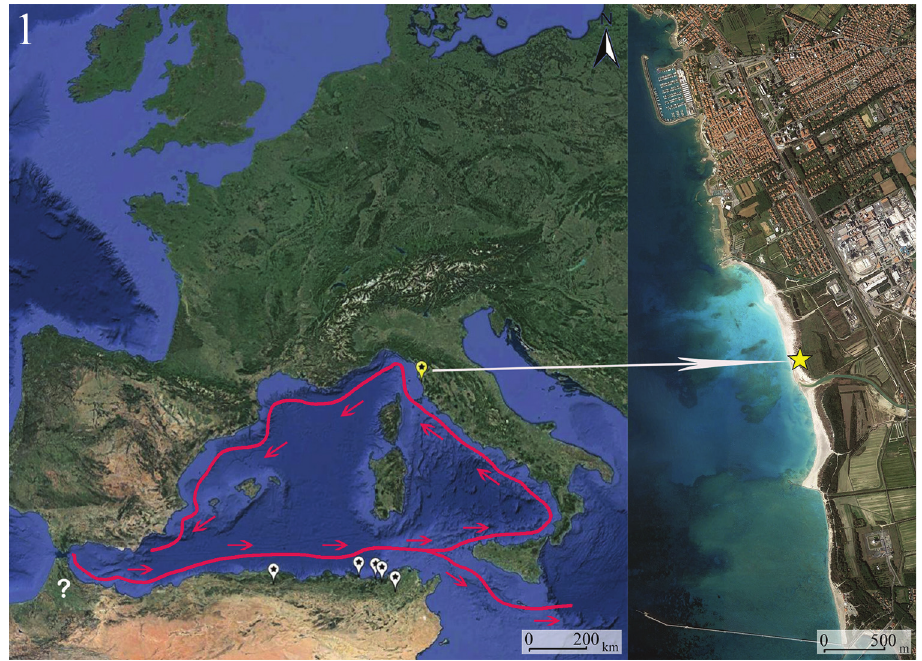
Figure 1. Distribution map of Belarima violacea (Lucas). Red line: Algerian current (see